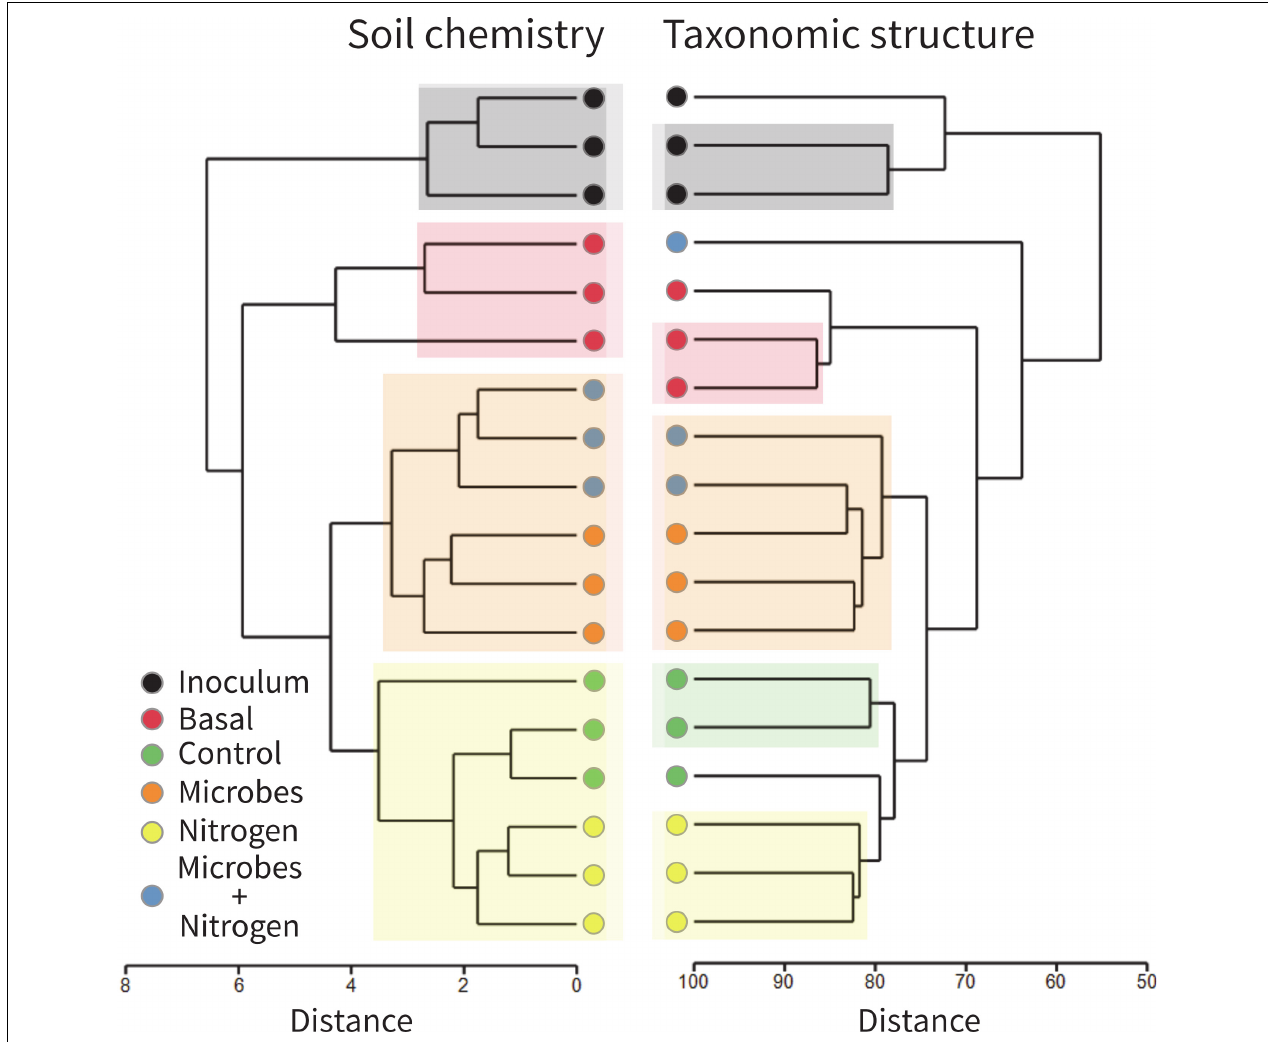
FIGURE 4 | Hierarchical cluster analysis with SIMPROF test of soil chemistry (left) and 16S amplicon sequencing (right) . Colorized boxes represent similar groups founded with SIMPROF